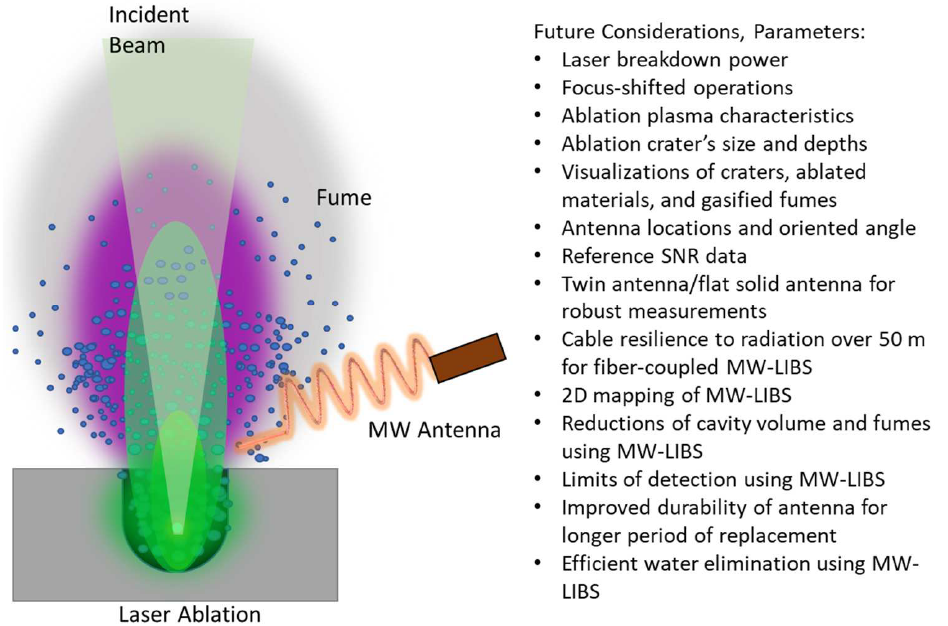
Figure 3. Illustration of microwave-enhanced plasma and parameters to be considered.